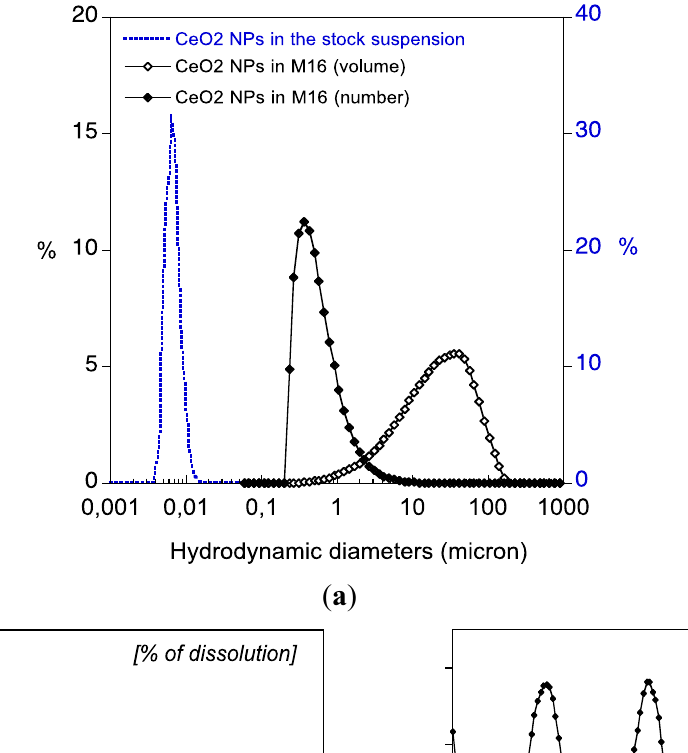
L3-edge of the e